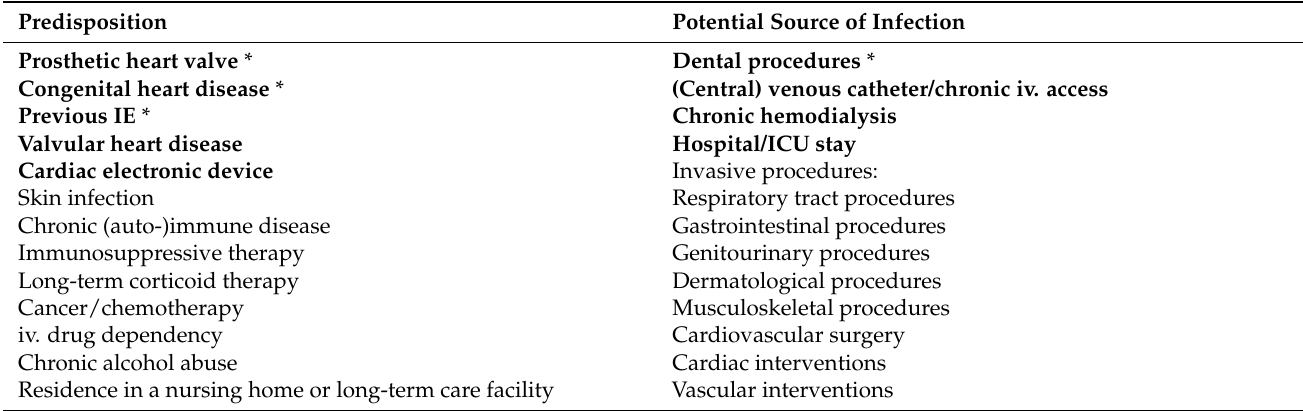
Predispositions of infective endocarditis and sources of infection in healthcare- associated infective endocarditis . Potential Source of